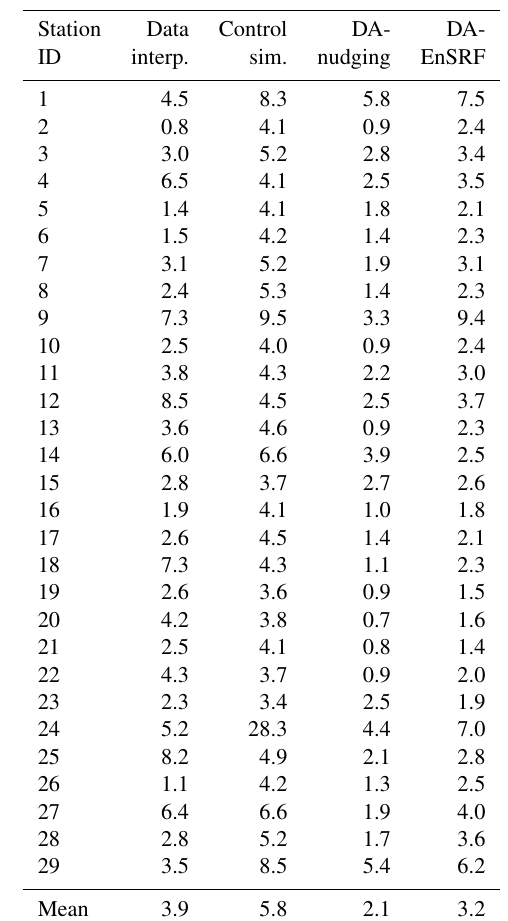
Table 1. Root mean square errors (in cm) of DI and DA considering all other stations except the one for which the index is computed. The RMSEs of the control simulation are also reported.